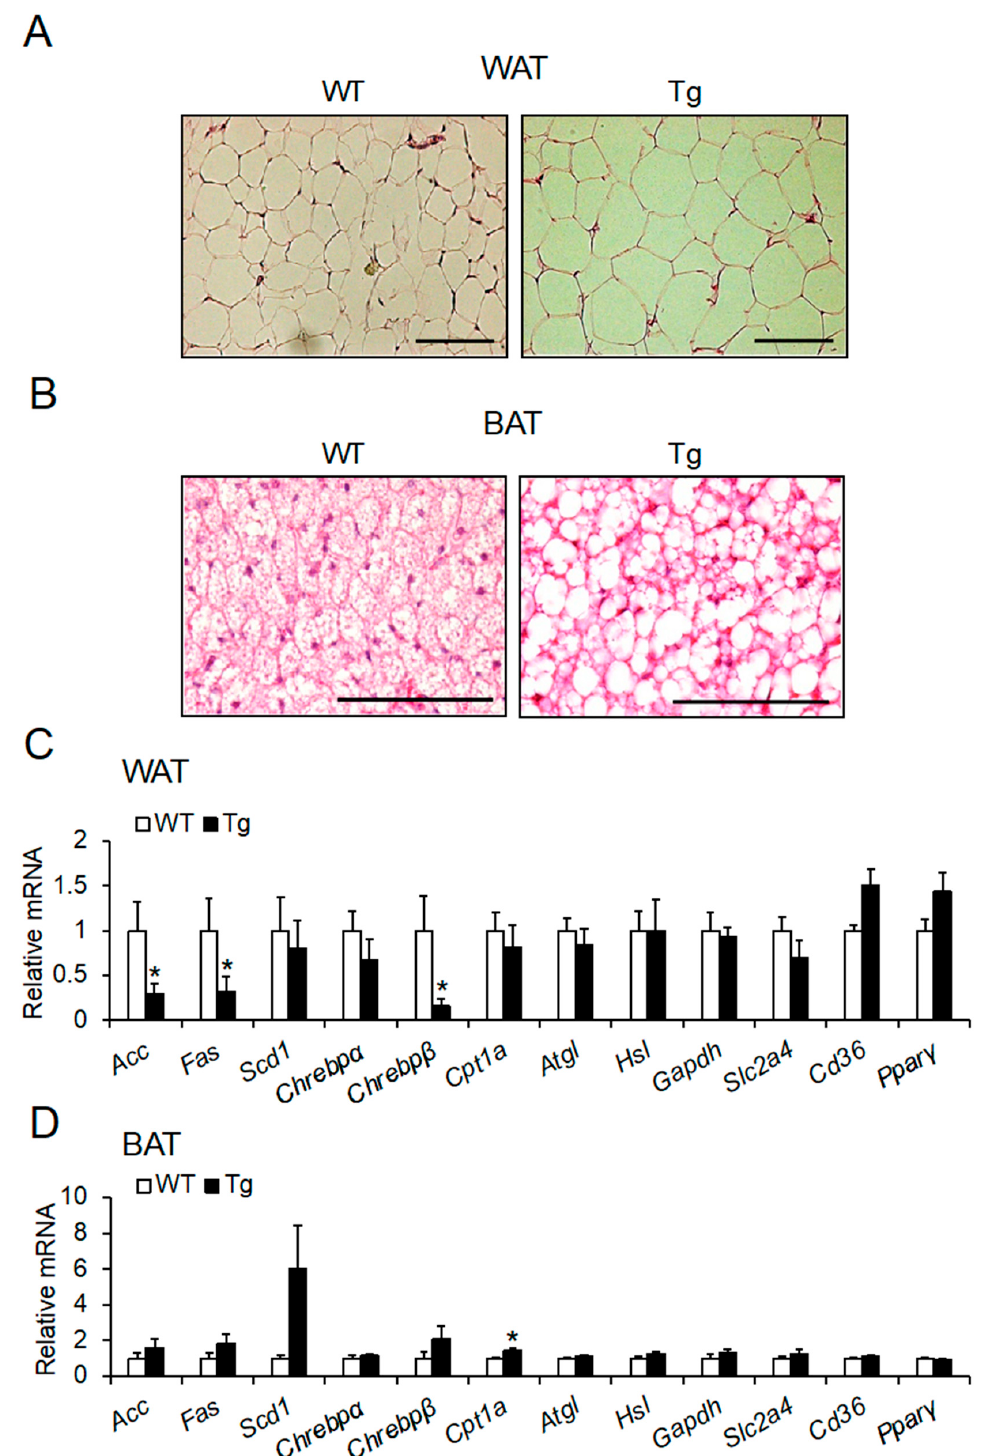
Figure 4. Morphological and mRNA expression analyses of adipose tissues of Npgl Tg mice. ( A , B ) Hematoxylin-eosin staining of epididymal WAT ( A ) and interscapular BAT ( B ) sections. Scale bars = 100 μ m. ( C , D ) The mRNA expression levels of lipid metabolism-related genes in inguinal WAT ( C ) and interscapular BAT ( D ). All statistical analyses were performed using Mann–Whitney U test. Each value represents the mean ± SEM ( n = 5–8). Asterisks indicate statistically significant differences (* p < 0.05). Npgl , neurosecretory protein GL; WT, wild-type; Tg, transgenic; WAT, white adipose tissue; BAT, brown adipose tissue.